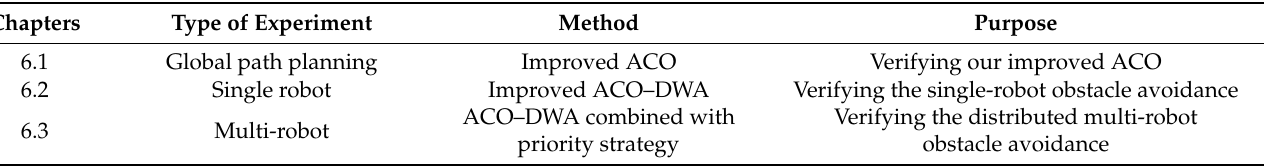
Table 2. Description of the simulation